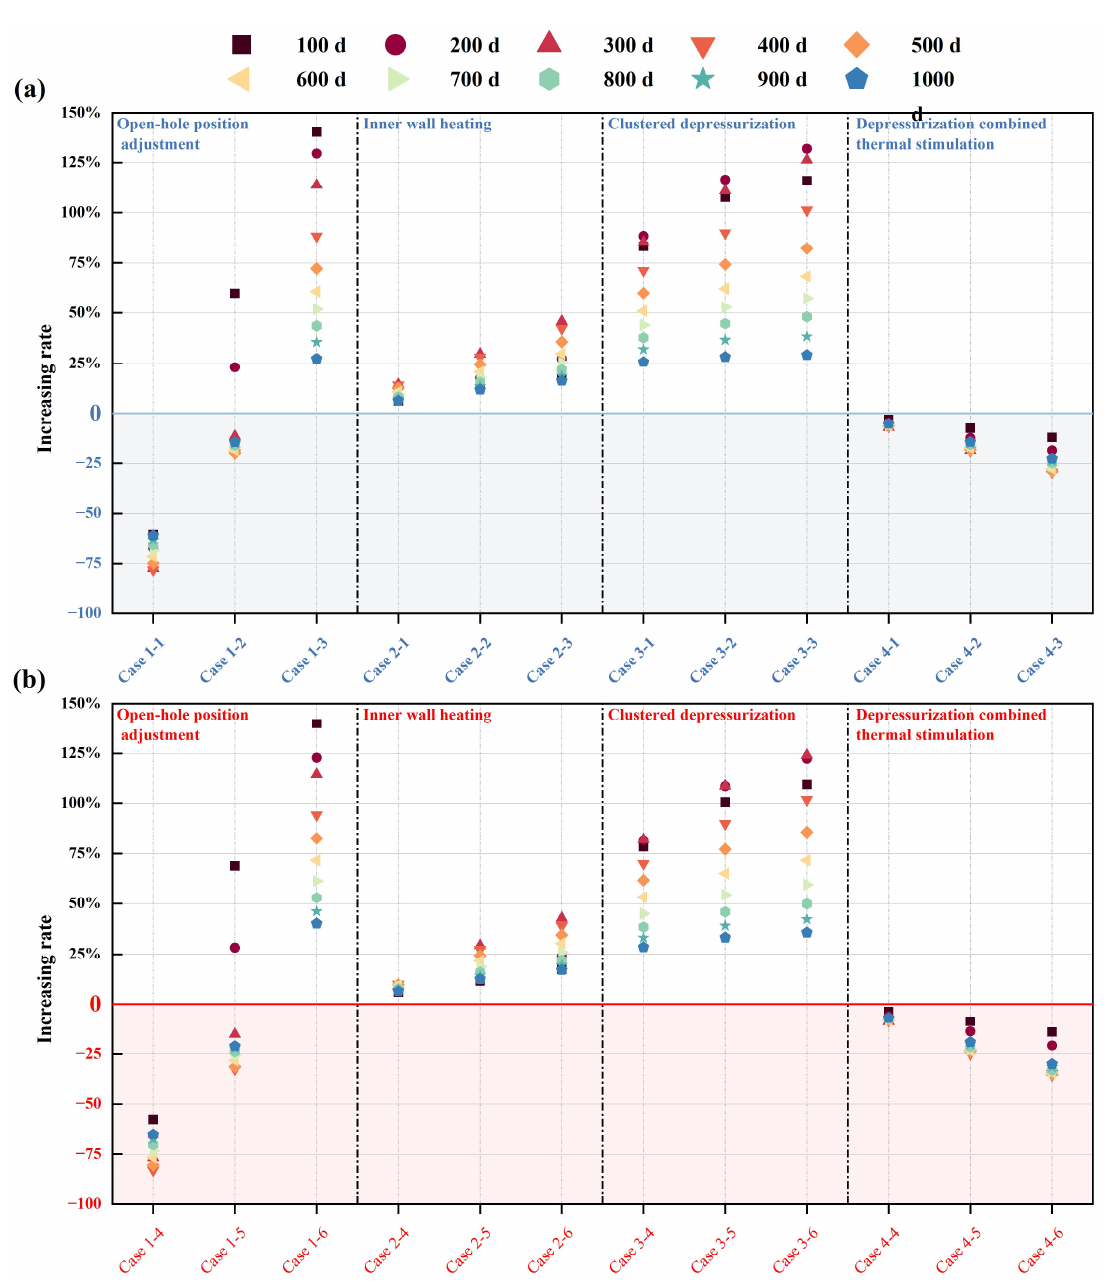
Figure 13. Increase rate of various production enhancement measures: ( a ) P = 1 Mpa and ( b ) P = 4 Mpa.